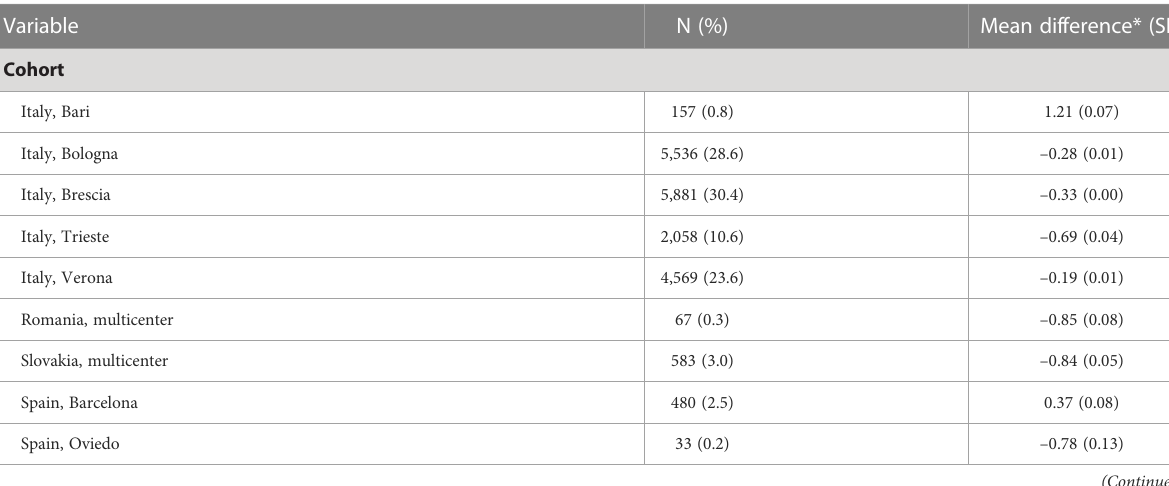
TABLE 1 Distribution of healthcare workers (HCW) by selected characteristics and mean difference between fi rst and second serologic measurements. Variable